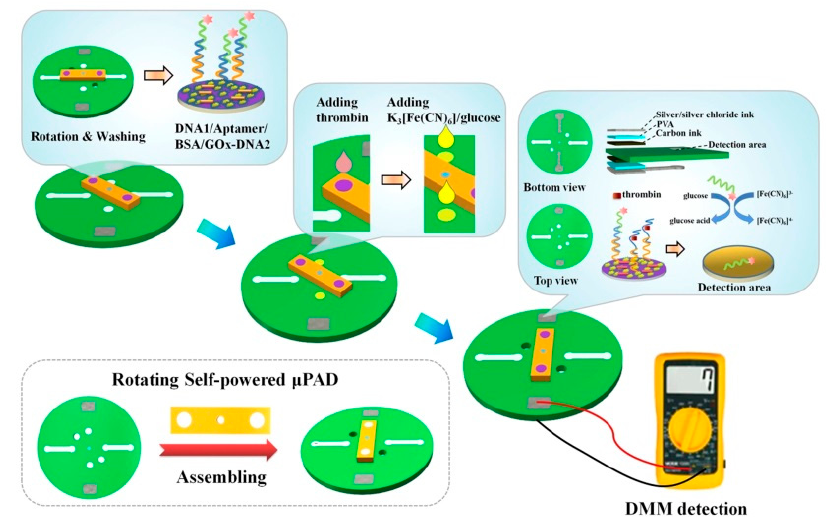
Figure 10. Schematic diagram of the rotational µ -EBFC-SPB and its working principle for thrombin detection [64]. Copyright 2022 Elsevier.